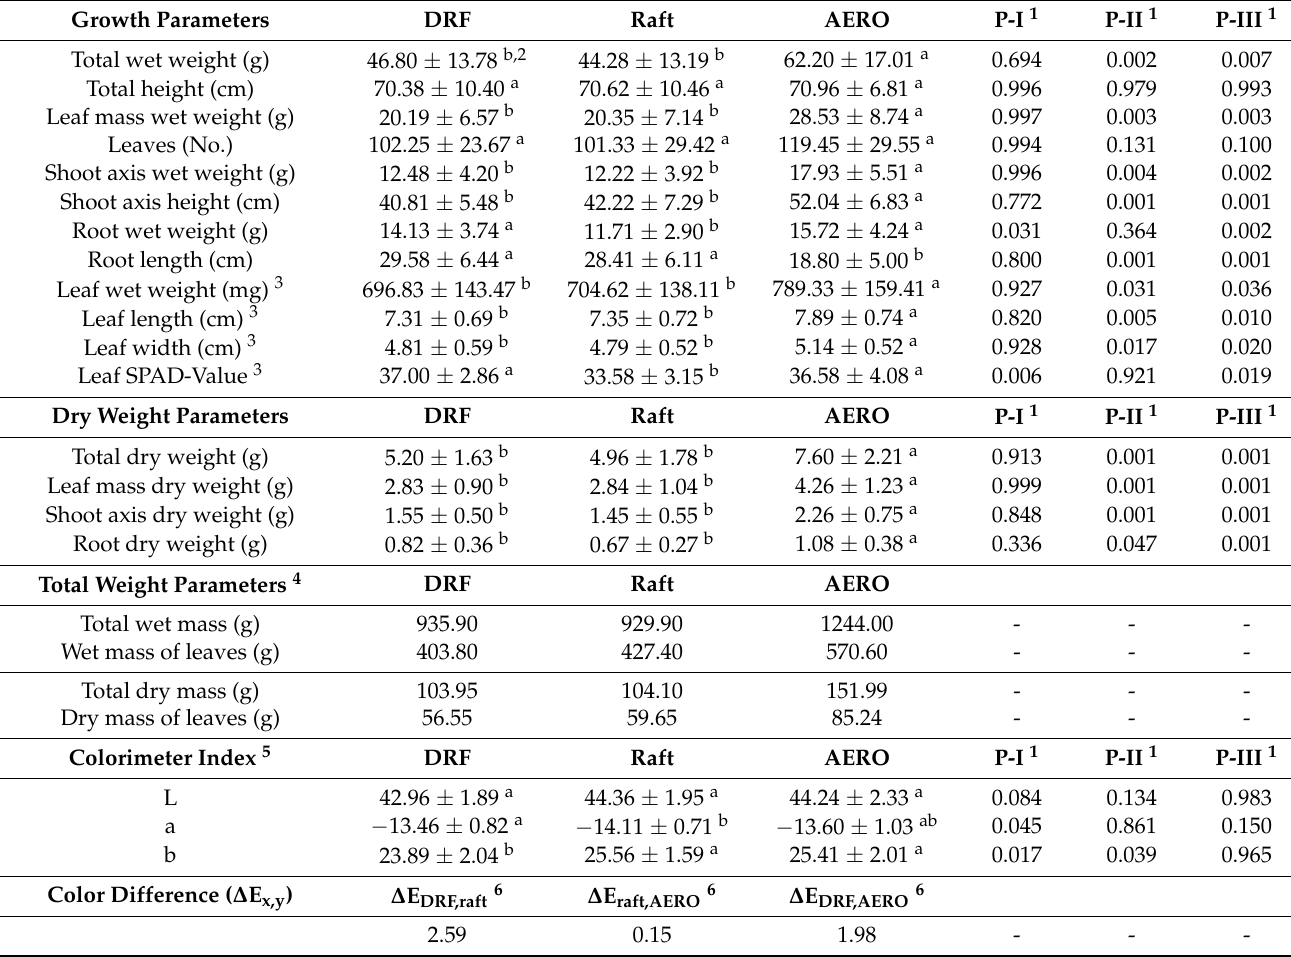
Table 2. Growth parameters (means ± SD) wet and dry mass of Ocimum basilicum in the three hydroponic subsystems (dynamic root floating technique: DRF, floating raft culture: raft, aeroponics: AERO) at the end of the experiment (39 days); different letters represent significant differences between the groups ( p < 0.05, n = 21). The third part of the table shows total and leaf mass of Ocimum basilicum (wet and dry) produced by one system over the experimental period without statistical comparison. The last two parts show the color differences of the plants from the colorimeter indexes L*a*b and the total color differences between the systems.